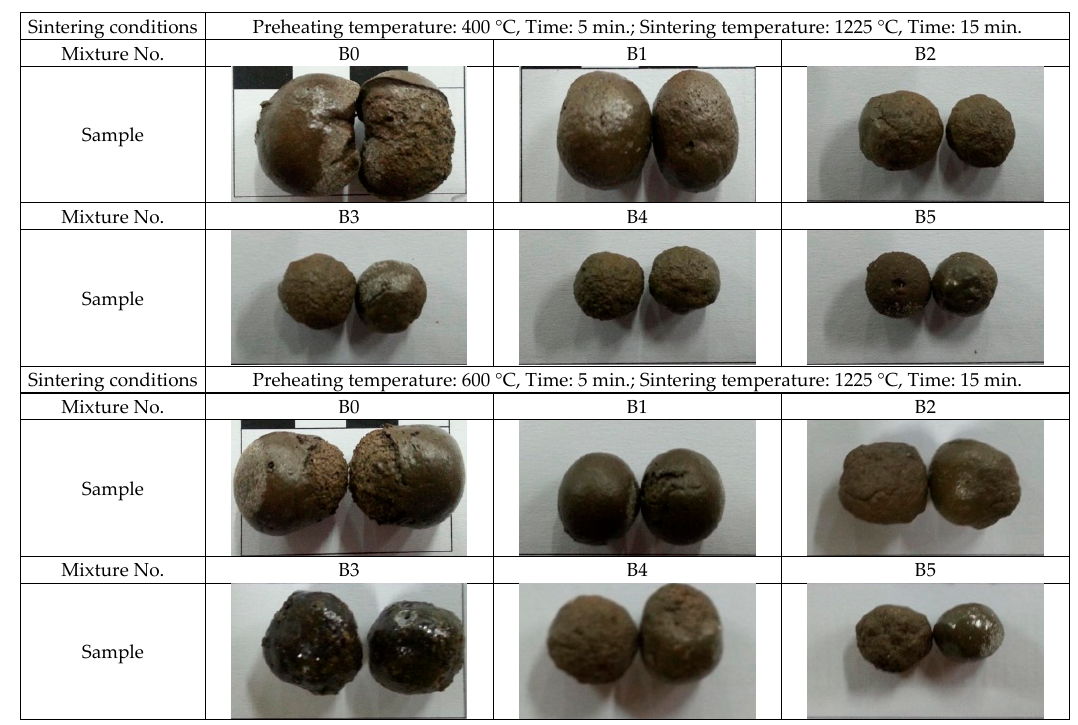
Figure 6. Appearance of paper sludge lightweight aggregate products (A series).